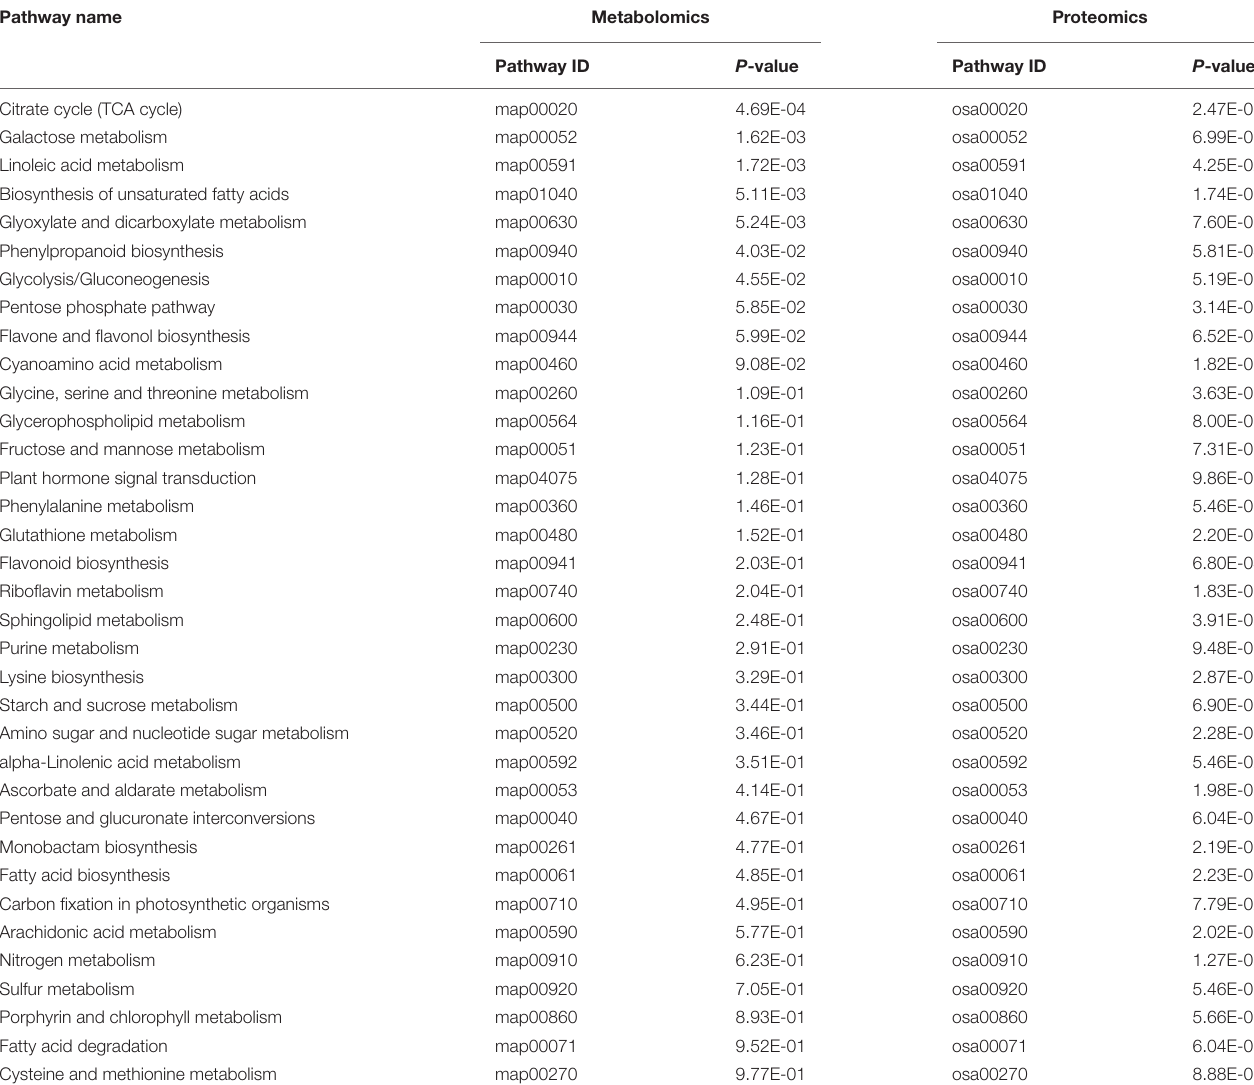
TABLE 2 | Proteins and metabolites involved in common pathways at